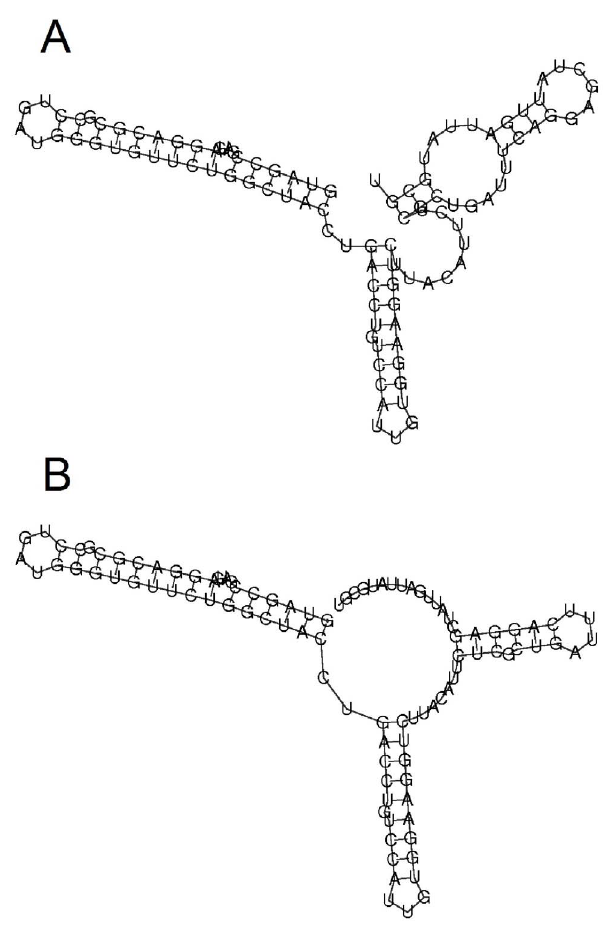
Figure 5. Predicted secondary structures of the E. coli ibpA thermometer [24] at 30 u C (left) and 45 u C (right). Energy minimization predictions were performed using Vienna’s RNAfold webserver, with the most recent energy parameters (Turner model, 2004).